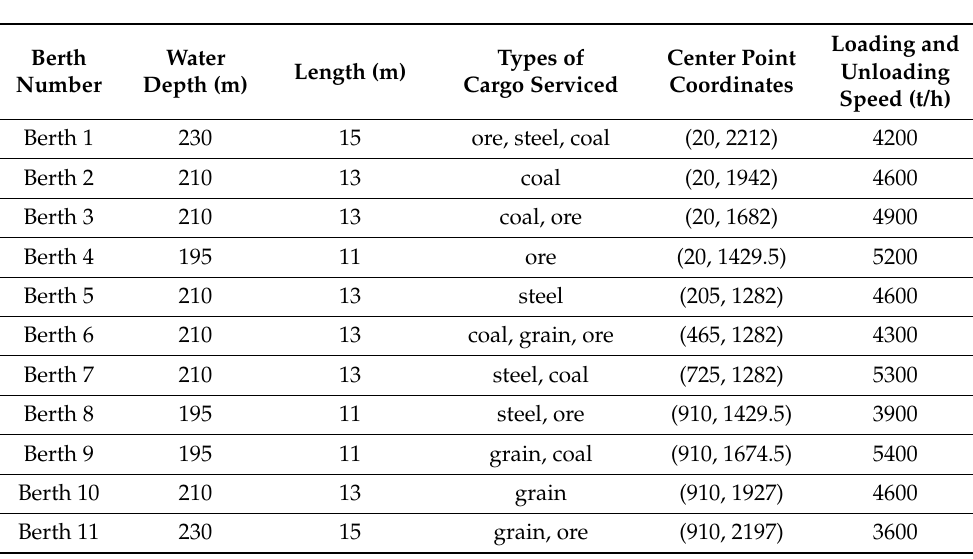
Table 3. Berth details.